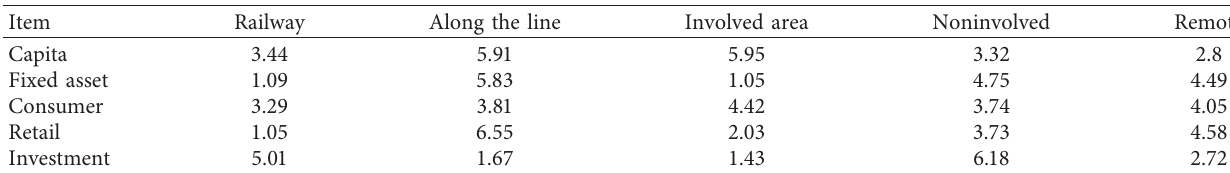
Figure 13: Economic regional circulation driven by high-speed railway. Table 15: Economic area circulation data.